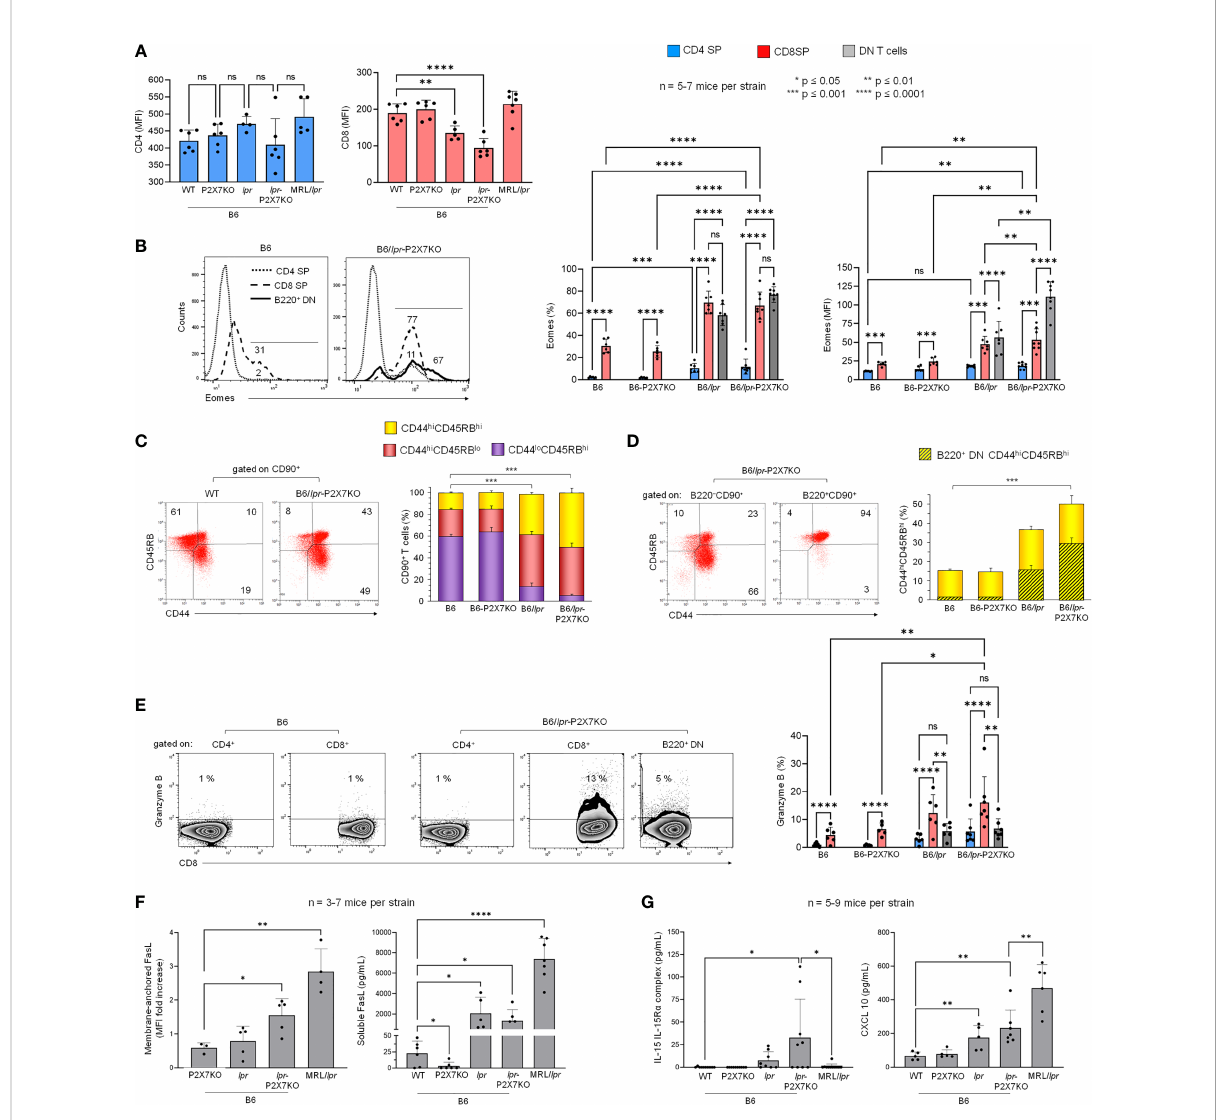
FIGURE 3 Cellular origin and activation state of B220 + DN T lymphocytes that accumulate in B6 /lpr-p2x7 KO mice. Spleen cells from 7- to 8-month-old female B6, B6- p2x7 KO, B6/ lpr and B6/ lpr - p2x7 KO and 4-month-old female MRL/ lpr mice were stained with either fl uorescent mAbs against the phenotypic and functional markers CD90, B220, CD4, CD8, CD44, CD45RB, FasL, Eomes, and Granzyme B or isotype controls and analyzed by fl ow cytometry. (A) Bar graphs show the mean (SD) of median fl uorescent intensity (MFI) values for CD4 and CD8 expression on SP CD90 + T cells from each mouse strain (n= 5-7 mice per strain). (B) Representative fl ow cytometry histograms of Eomes intracellular staining gated on CD4 SP, CD8 SP and B220 + DN CD90 + T cells. Bar graphs show the percentage of Eomes + cells (left) and Eomes MFI (right) in gated CD4 + ( ), CD8 + ( ), and B220 + DN ( ) CD90 + T cells from each mouse strain. Data are expressed as mean (SD) of 5-7 mice per strain. (C, D) Representative fl ow cytometry plots of CD44/CD45RB staining. CD44 versus CD45RB expression allowed to determine the percentages of naïve (CD44 lo CD45RB hi ) and effector/memory (either CD44 hi CD45RB lo or CD44 hi CD45RB hi ) cells in whole CD90 + T cells (C) and in B220 − SP (either CD4 or CD8) and B220 + DN CD90 + T cells (D) . Stacked bar graphs show (C) the respective proportions of naïve (CD44 lo CD45RB hi , ) and effector/memory (either CD44 hi CD45RB lo or CD44 hi CD45RB hi ) cells in CD90 + T cells and (D) the proportion of B220 + DN cells ( ) in CD44 hi CD45RB hi effector/memory CD90 + T cells ( ) from each mouse strain. Data are expressed as mean (SD) of 5-7 mice per strain. (E) Representative fl ow cytometry dot plots of Granzyme B/CD8 staining in gated CD4 SP, CD8 SP and B220 + DN CD90 + T cells. Bar graphs show the percentage of Granzyme B + cells in gated CD4 + ( ), CD8 + ( ), and B220 + DN ( ) CD90 + T cells from each mouse strain. Data are expressed as mean (SD) of 5-7 mice per strain. (F, G) Membrane-anchored FasL ( F , left) on CD90 + T cells from each mouse strain. Data are shown as mean fold increase (SD, n = 3-7 mice per strain) in FasL MFI on CD90 + T cells relative to staining with an isotype control mAb. Serum levels of soluble FasL ( F , right), IL-15/IL-15R complex ( G, left), and CXCL10 ( G, right) measured by ELISA in the sera of 6- to 7-month-old female B6, B6- p2x7 KO, B6/ lpr , and B6/ lpr - p2x7 KO mice and 4-month-old female MRL/ lpr mice Data are shown as mean (SD) of 5-7 mice per strain. Each dot in the bar graphs represents an individual mouse. Error bars in graphs show SD. Asterisks above horizontal lines indicate statistically signi fi cant differences assessed with unpaired two-tailed t -test in (A, C, D, F, G) and two-way ANOVA with a Tukey post hoc test in (B, E) . *p ≤ 0.05, **p ≤ 0.01, ***p ≤ 0.001, ****p ≤ 0.0001 and ns, not signi fi